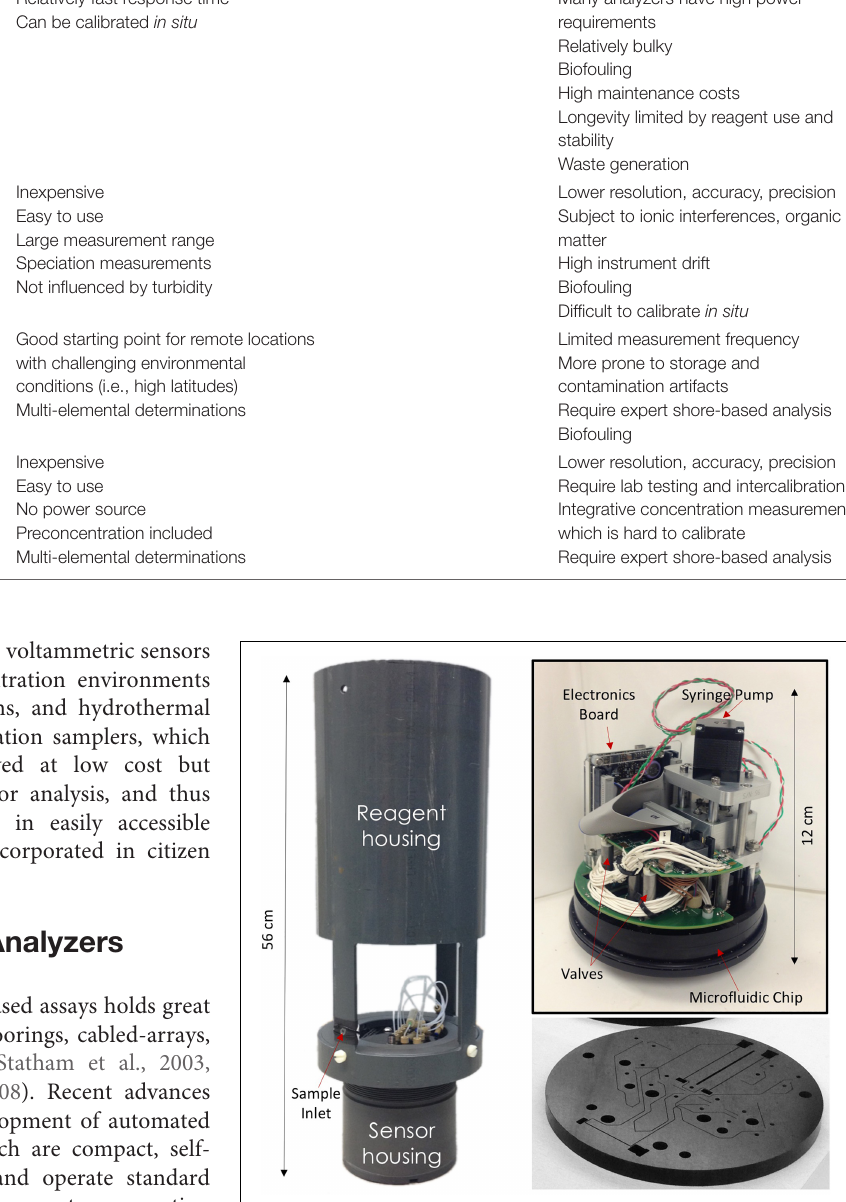
FIGURE 3 | Lab-on-Chip phosphate analyzer. Left: fully assembled sensor with reagent housing. Top right: Analyzer prior to placement in watertight housing. Bottom-right: microfluidic chip showing micromilled fluidic manifold and absorbance flow cells prior to assembly. From Grand et al.